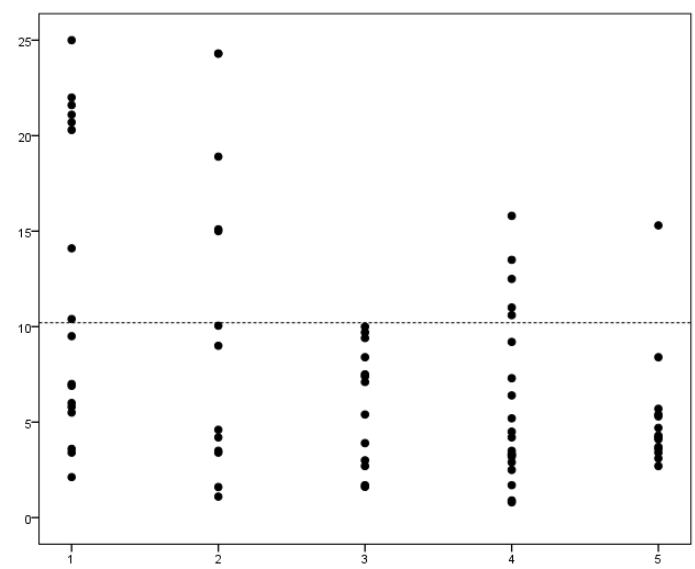
Figure 1. Dotplot showing results of blood L-lactate concentration in 77 roe deer. X -axis, outcome after hospitalization: (Group 1) spontaneously dead; (Group 2) euthanized for welfare reasons; (Group 3) recovered and released; (Group 4) euthanized for other reasons; (Group 5) hunted deer. Y -axis, L-lactate concentration (mmol/L). Dotted line: cutoff selected based on ROC curve coordinates, having a 100% specificity in discriminating between Group 1 and 3. Table 1. Results of descriptive statistics on blood L-lactate concentrations among different groups of